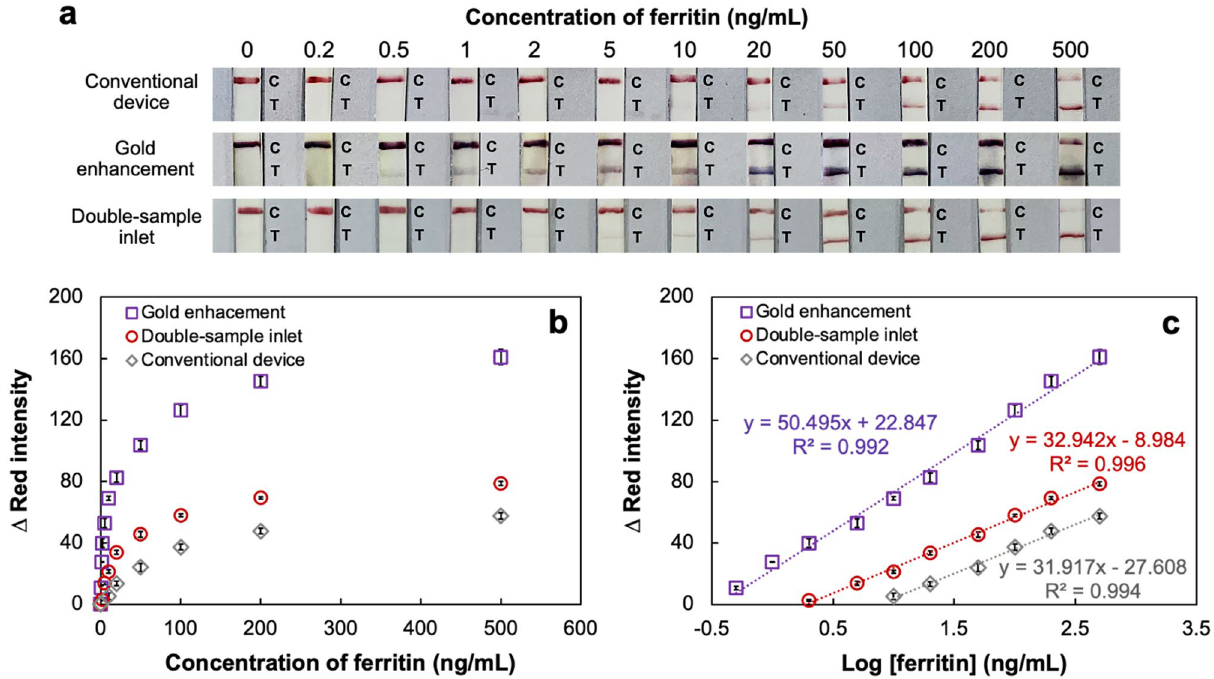
Figure 5. ( a ) Photographs after applying ferritin solutions between 0 and 500 ng/mL on conventional, gold enhancement and double-sample inlet devices; ( b ) the relationship between the Δred intensity and the concentration of ferritin examined in triplicate (n = 3); ( c ) the linearities of the Δred intensity versus the logarithm of the ferritin concentration (n = 3).